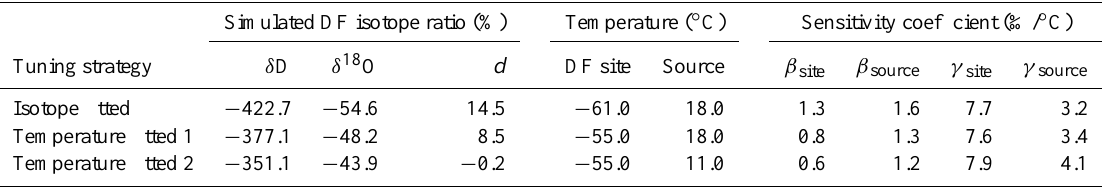
Table 2. Test of β site sensitivity to the source and site